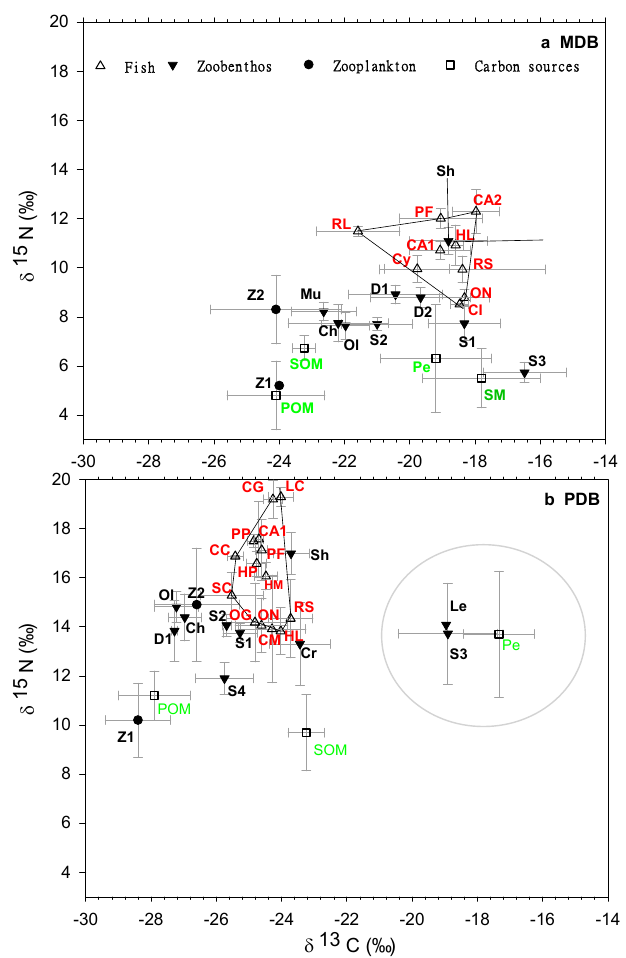
Figure 2. Dual stable isotope indicators (mean ± SD) of the food web structure in MDB ( a ) and PDB ( b ) during the period April 2010 to March 2011. Error bars represent the standard deviation of different months. Fish: Hypophthalmichthys molitrix Val. , HM; Pseudorasbora parva , PP; Coilia grayii Richardson , CG; Leucosoma chinensis , LC; Hemiculter leucisculus , HL; Rasborinus lineatus , RL; Rhodeus sinensis Gunther , RS; Squaliobarbus curriculus , SC; Cirrhinus molitorella , CM; Oreochromis niloticus , ON; Carassius auratus , CA1; Cyprinus carpio , CC; Hypostomus punctatus , HP; Onychosotoma gerlachi , OG; Pelteobagrus fulvidraco , PF; Channa argus , CA2; Ctenopharyngodon idellus , CI . Invertebrate: Bellamya spp., S1; Angulyagra polyzonata , S2; Radix spp., S3; Pomacea canaliculata , S4; Mussel, Mu; shrimp, Sh; Crab, Cr; Leech, Le; Dragonfly larva, D1; Damselfly larva, D2; Oligochaetes, Ol; Chironomidae larvae, Ch; Cladocerans, Z1; Copepods, Z2; Basal resource carbon: Particle organic matter, POM; Sediment organic matter, SOM; Submerged macrophyte, SM; Periphyton, Pe . Two extreme positions (gray ellipse) of rare benthic invertebrates were collected from the shore in PDB.